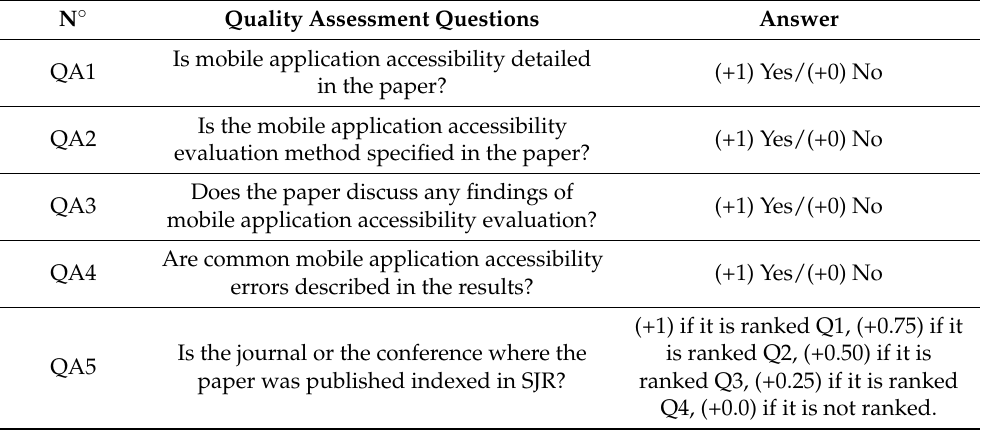
Table 1. Document quality evaluation